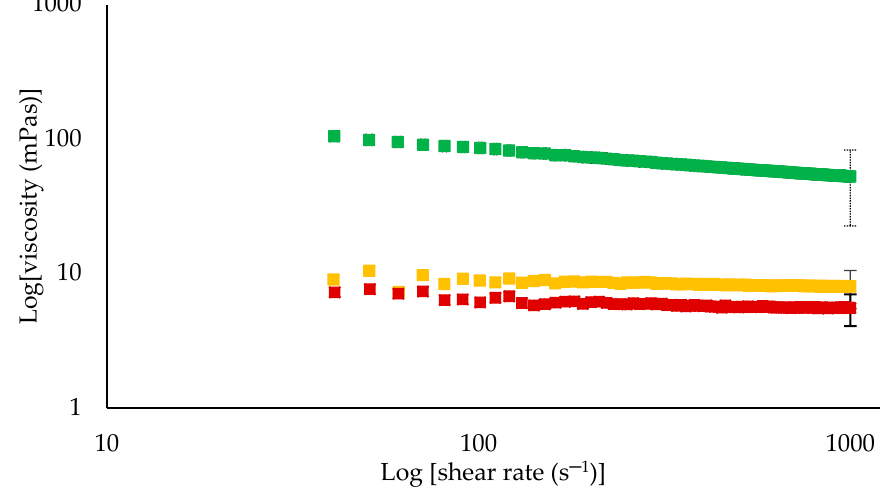
Figure 4. Log–log plots of viscosity as a function of shear rate for retentates obtained by ultrafiltration of skim milk at 5 ± 0.5 ( ■ ), 20 ± 0.5 ( ■ ), or 50 ± 0.5 °C ( ■ ). Values are raw mean ± standard deviation of duplicate analysis from triplicate runs at each test temperature.